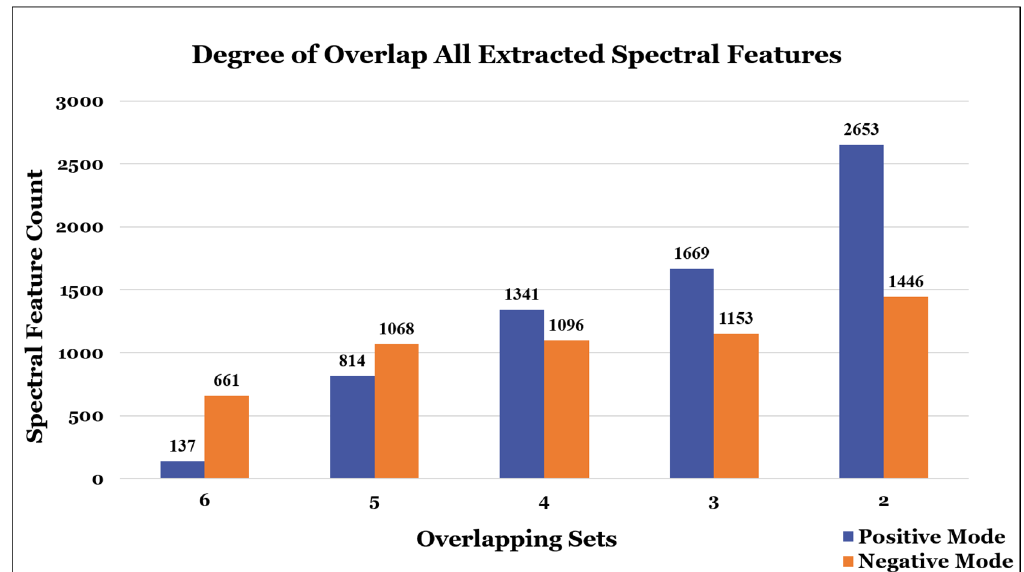
Figure 5. Degree of overlap for all extracted spectral features. The graph shows the total number of overlapping features found between the full extracted list of spectral features from 6 of the participants that provided raw data. More overlap was observed in the negative mode data compared to positive mode